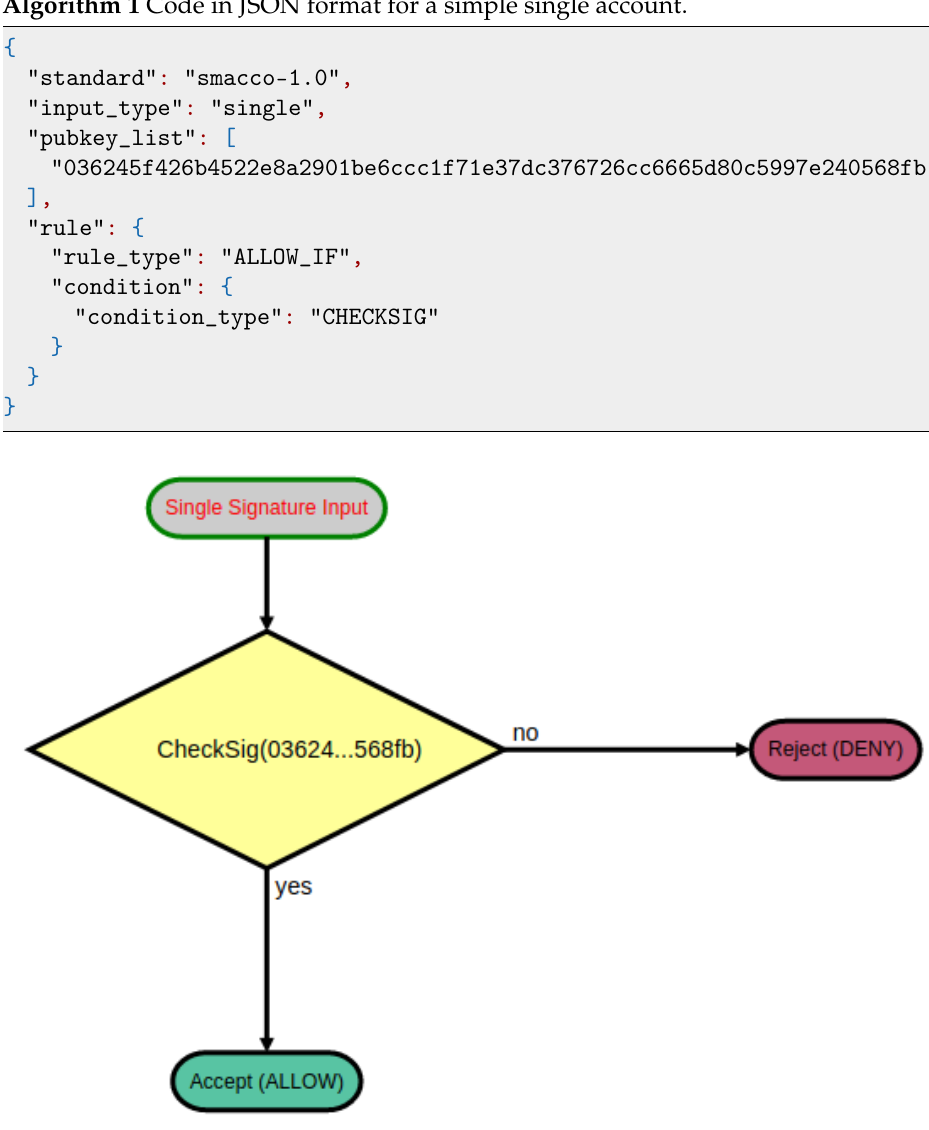
Figure 1. Flowchart of the single account presented in Algorithm